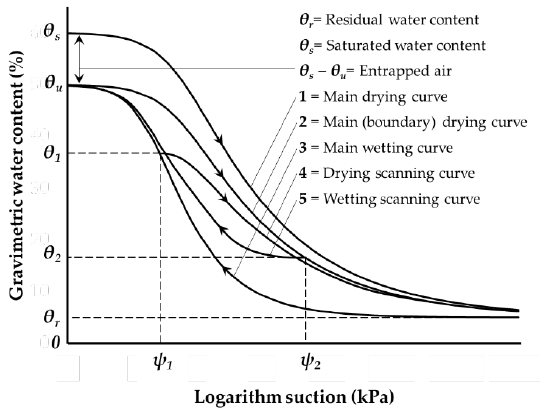
Figure 1. Schematic illustration of soil water hysteresis curves.